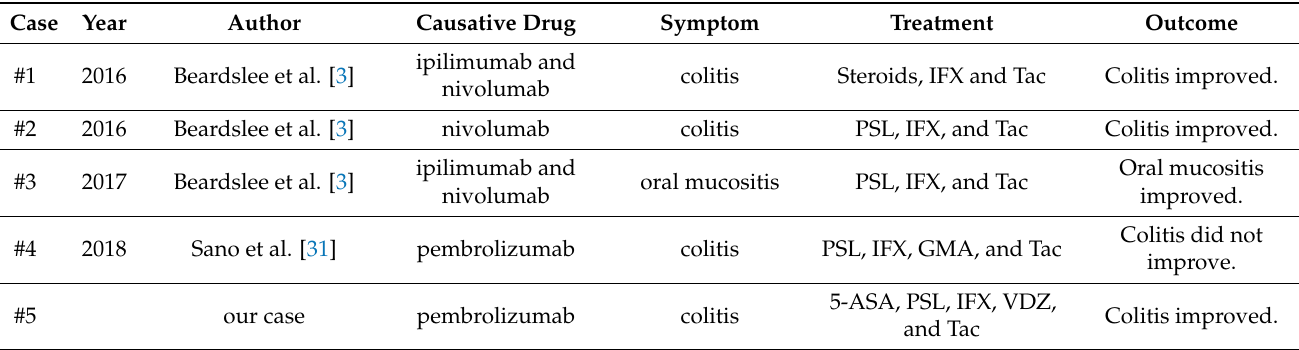
Table 2. Literature review of gastrointestinal immune-related adverse events for which tacrolimus was administered. Case